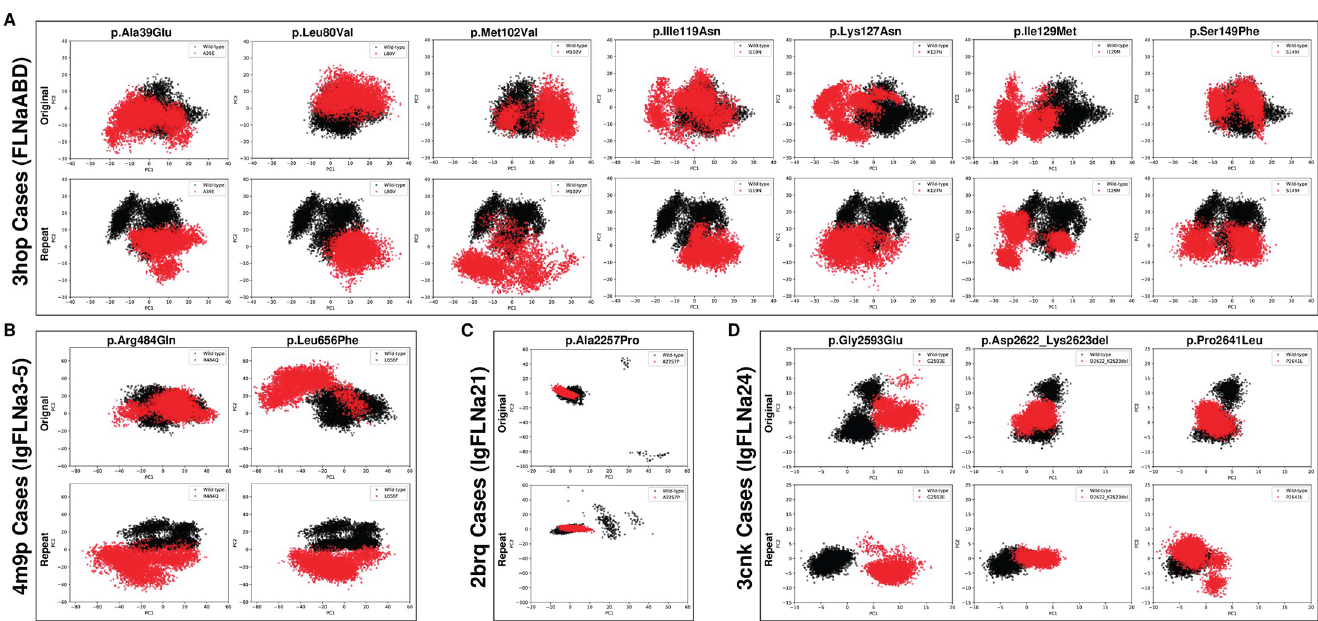
Fig 4. Conformational spaces of the (A) FLNaABD, (B) IgFLNa3-5, (C) IgFLNa21 and (D) IgFLNa24 variants, compared to the wild-type. The conformations collected in the molecular dynamics simulations are visualized by using the first two principal components.